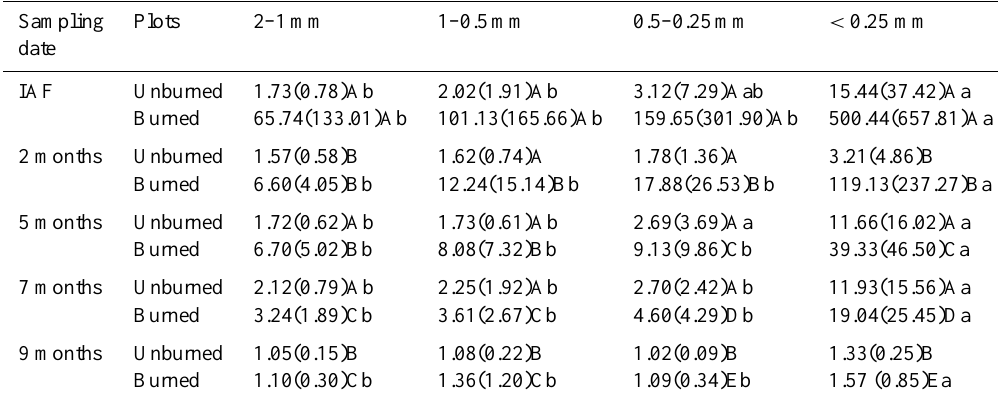
Table 4. Water drop penetration time (s) in terms of the different size fractions for unburned and burned plots for different sampling dates. Statistical comparisons were carried out between times (upper case) and in each plot (different fractions in the same plot) during the studied sampling dates (lower case). Different letters represent significant differences at p < 0.05.